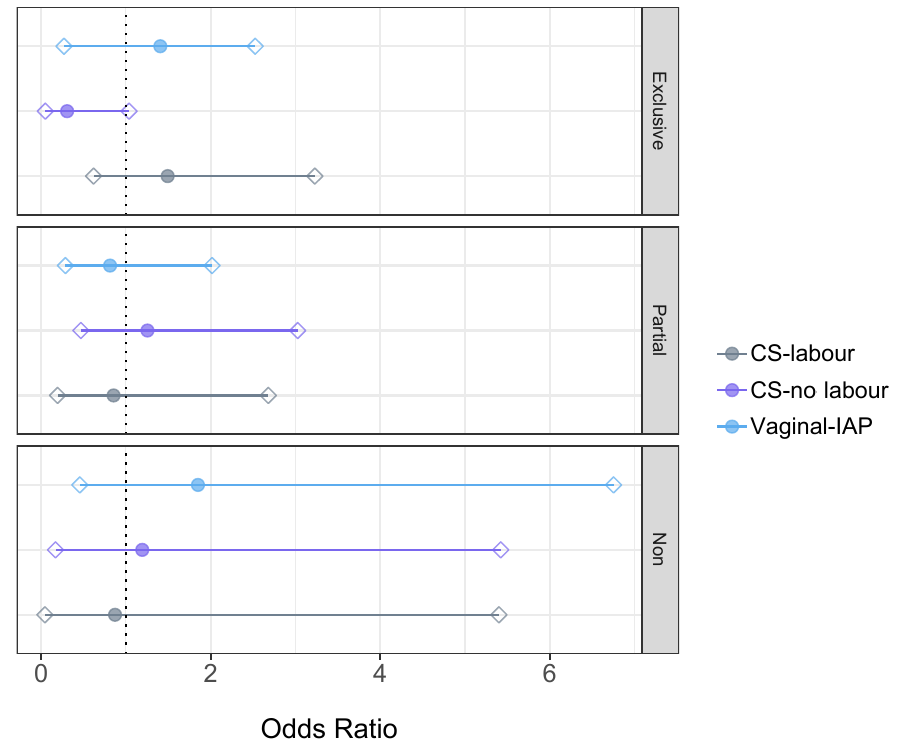
Figure 3. Likelihood (OR, 95% CI) of gut microbial colonization with qPCR Bifidobacterium longum subsp. infantis according to birth mode within exclusively breastfed, partially breastfed and non- breastfed infants at 3 months of age. Crude ORs from logistic regression are presented. Vaginal-no IAP is the reference group. The circle indicates the odds ratio and rhombuses indicate 95% CIs. The dotted line shows an odds ratio of